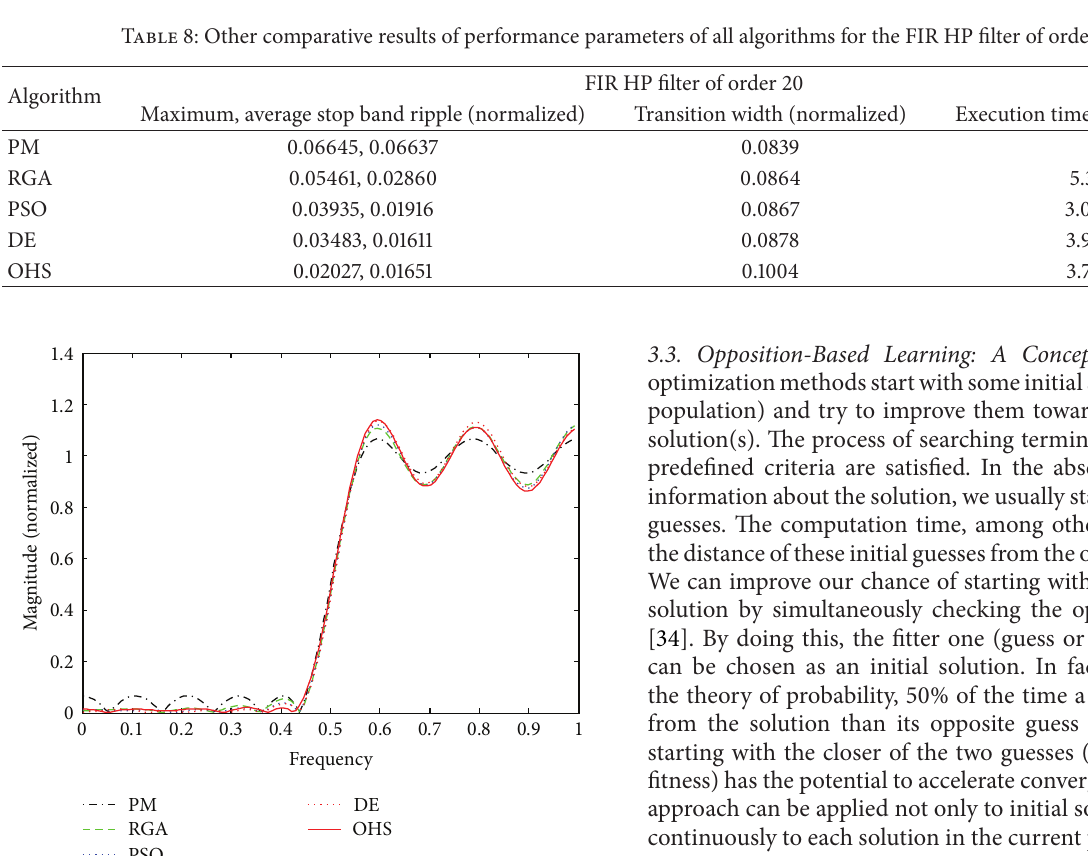
[42], applies the same memory consideration, pitch adjust- ment, and random selection as the basic HS algorithm,